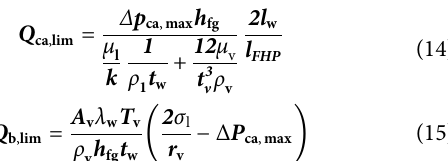
Frontiers in Energy Research |